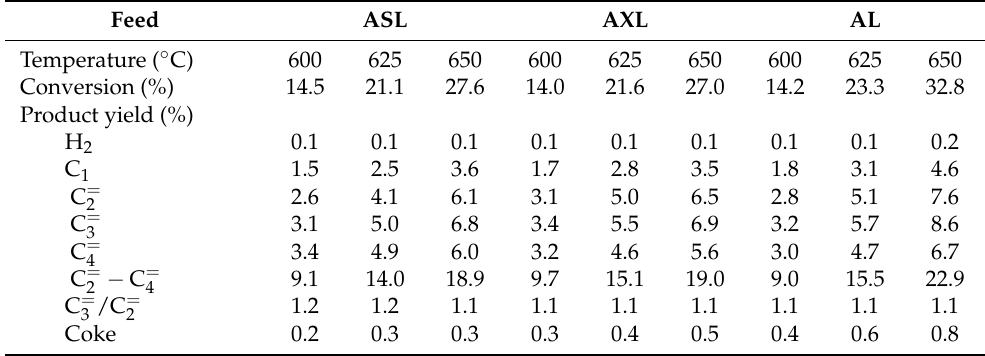
Table 6. Conversion and yields of product for the thermal cracking of different crude oils [55]. Feed